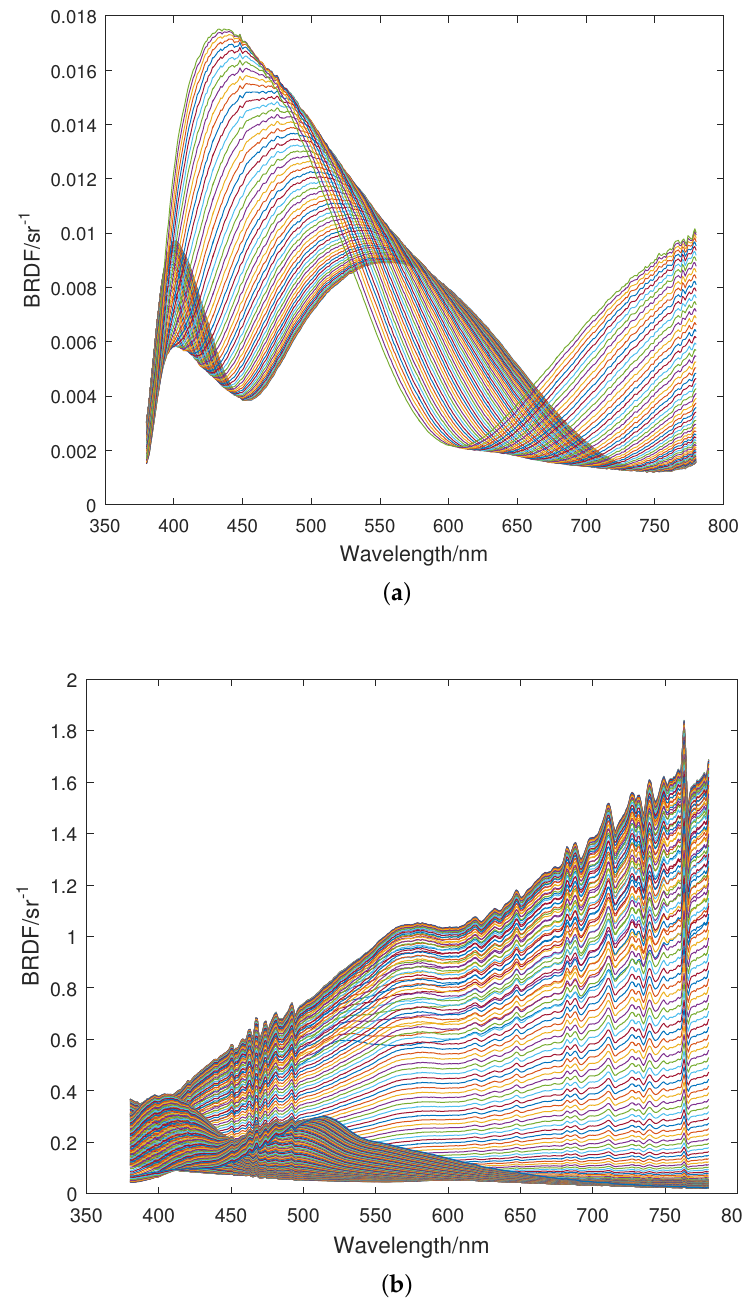
Figure 3. Interpolated spectral BRDF data for a highly goniochromatic ( a ) interference- and ( b ) diffraction-based special effect coating. The spectral BRDFs correspond to geometries with a fixed θ asp = 10 ◦ and values of θ i from 10 ◦ to 70 ◦ (angular step of (1/3) ◦ ) in ( a ), and to geometries with a fixed θ i = 10 ◦ and values of θ asp from − 60 o to 10 ◦ (angular step of (1/3) ◦ ) in ( b ); ( a ) Interference-based special effect coating (Colorstream R (cid:13) T20-04 WNT Lapis Sunlight); ( b ) Diffraction-based special effect coating (SpectraFlair R (cid:13) Silver